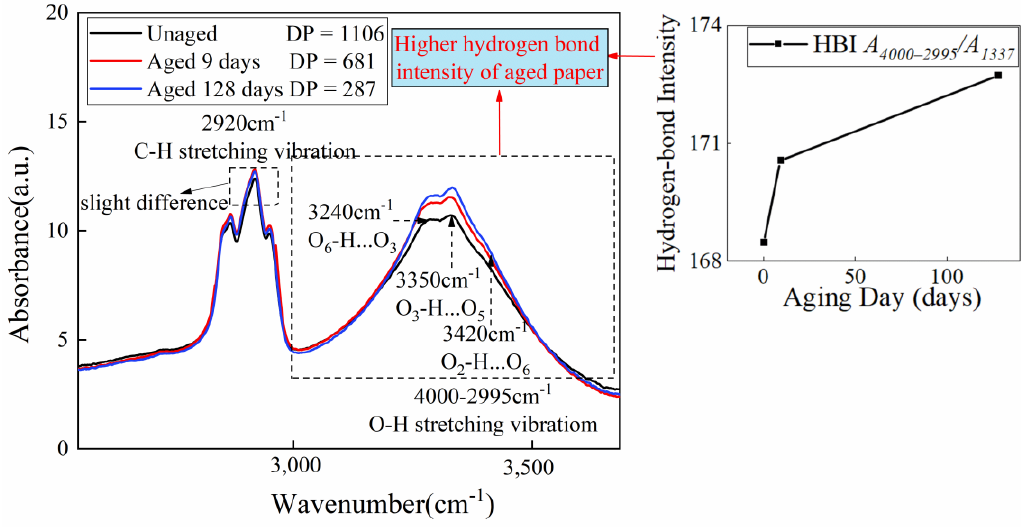
Figure 9. FTIR spectra of insulating paper aged 0, 9, and 128 days including the C-H and O-H stretching vibration bands.